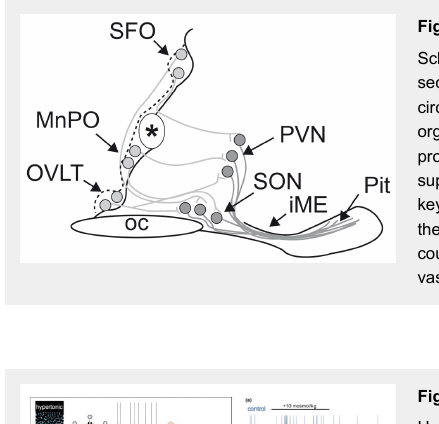
Upper left: Cell autonomous osmoreception in vasopressin neurons. Changes in osmolality cause inversely proportional changes in soma volume. Shrinkage activates nonselective cation channels (NSCCs) and the ensuing depolarisation increases action potential firing rate and vasopressin (VP) release from axon terminals in the neurohypophysis. Increased VP levels in blood enhance water reabsorption by the kidney (antidiuresis) to restore extracellular fluid osmolality toward the set point. Hypotonic stimuli inhibit NSCCs. The resulting hyperpolarization and inhibition of firing reduces VP release and promotes diuresis. Upper right: Whole cell current clamp recordings from isolated MNCs (left) and averaged data from multiple cells show that the depolarising and action potential firing responses induced by a hypertonic stimulus are significantly enhanced in the presence of 100 nM Ang II. Lower right: Hypothetical events mediating central Ang II enhancement of osmosensory gain. Ang II released by afferent nerve terminals (e.g. during hypovolaemia) binds to AT1 receptor (AT1R) coupled to G proteins such as Gq or/and G12/13. Activated G proteins signal through phospholipase C (PLC) and protein kinase C (PKC) to activate a RhoA-specific guanine nucleotide exchange factor (RhoA–GEF), such as p115RhoGEF or LARG (leukaemia-associated Rho guanine–nucleotide exchange factor) Activation of RhoA–GEF converts inactive cytosolic RhoA (RhoA–GDP) into active, membrane-associated RhoA–GTP by promoting the exchange of GDP to GTP. Activated RhoA induces actin polymerisation and increases submembrane F-actin density to enhance the mechanical gating of non-specific cation channels. (From [81]: Prager-Khoutorsky M, Bourque CW. Osmosensation in vasopressin neurons: changing actin density to optimize function. Trends Neurosci. 2010;33:76–83. © Elsevier, Oxford, UK, with kind